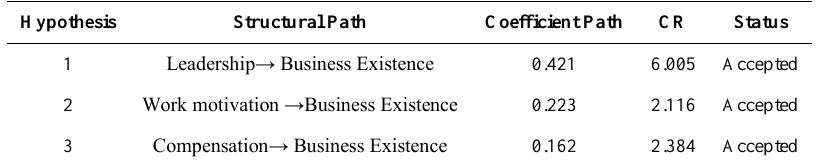
Table 7. Standard Structural Parameters for Estimating Direct Effect Path Analysis Model Hypothesis Structural